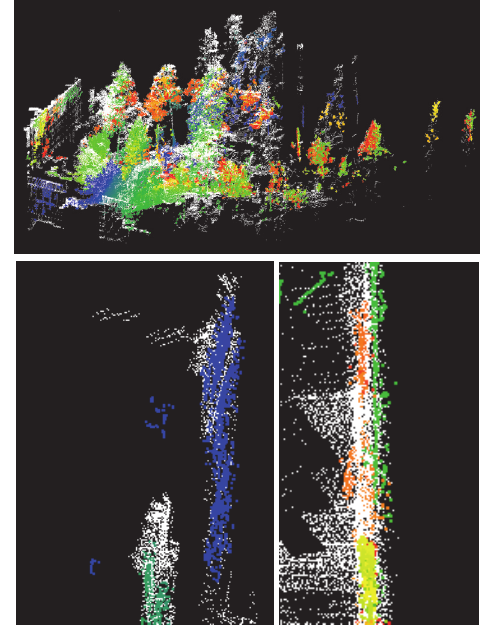
Figure 14. Upper image: An overview of the final resuts after the registration and the time-based transformation. Lower row: two details how BLS laser points (colorful points) are aligned with UAV data (white points) at the wall